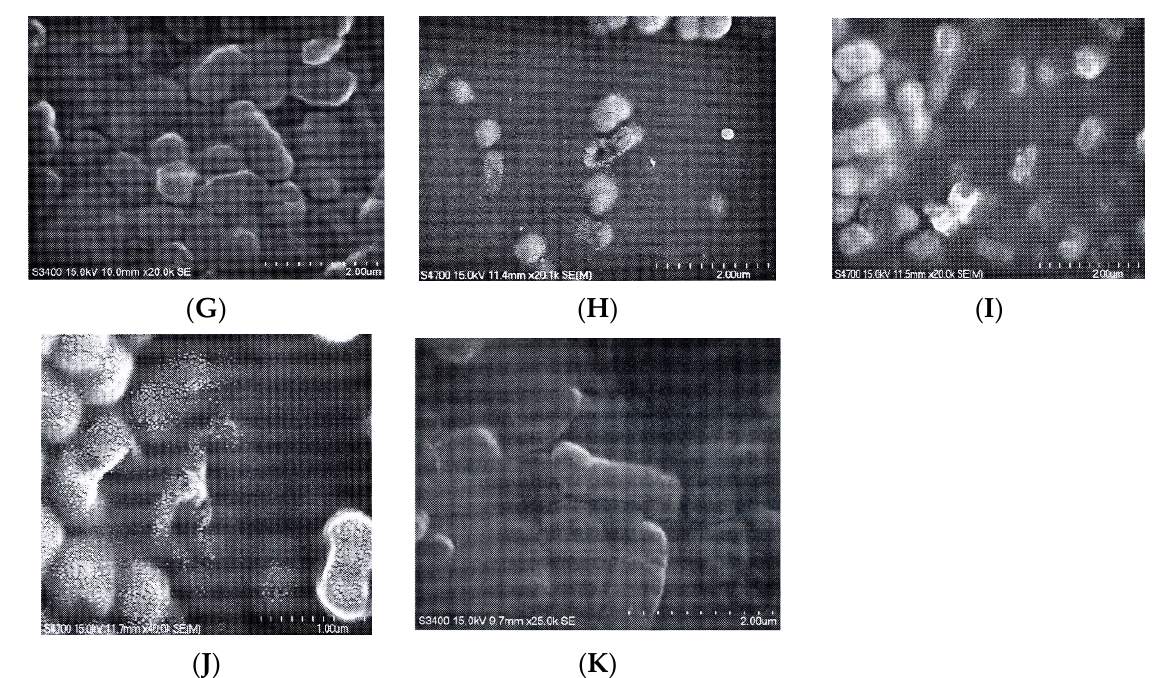
Figure 3. Scanning electron microscopy (SEM) observation. ( A ): Ab3327 without extract; ( B ): Ab3327 with leaf SFE extract B; ( C ): Ab3327 with Anethole; ( D ): Ab3327 with Anisyl aldehyde; €: Ab3327 with Anisyl acetone; ( F ): Ab3327 with Anisyl alcohol; ( G ): Pa4016 without extract; ( H ): Pa4016 with leaf SFE extract B; ( I ): Pa4016 with Anisyl aldehyde; ( J ): Pa4016 with Anisyl acetone; ( K ): Pa4016 with Anisyl alcohol.